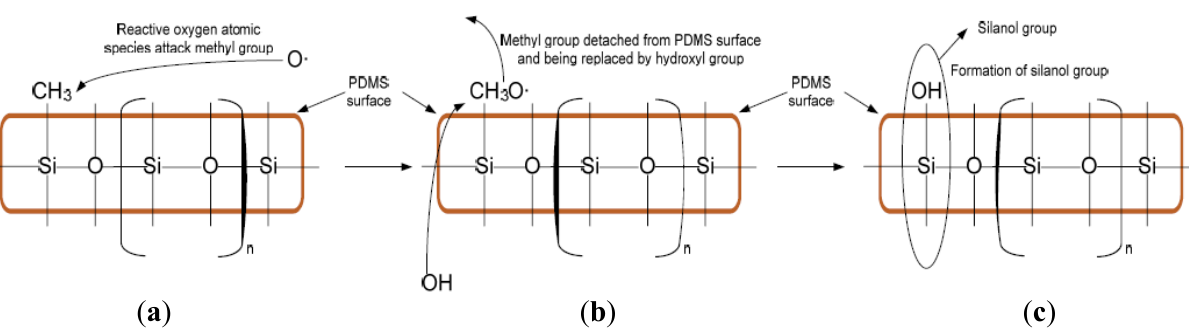
O – is detached 3